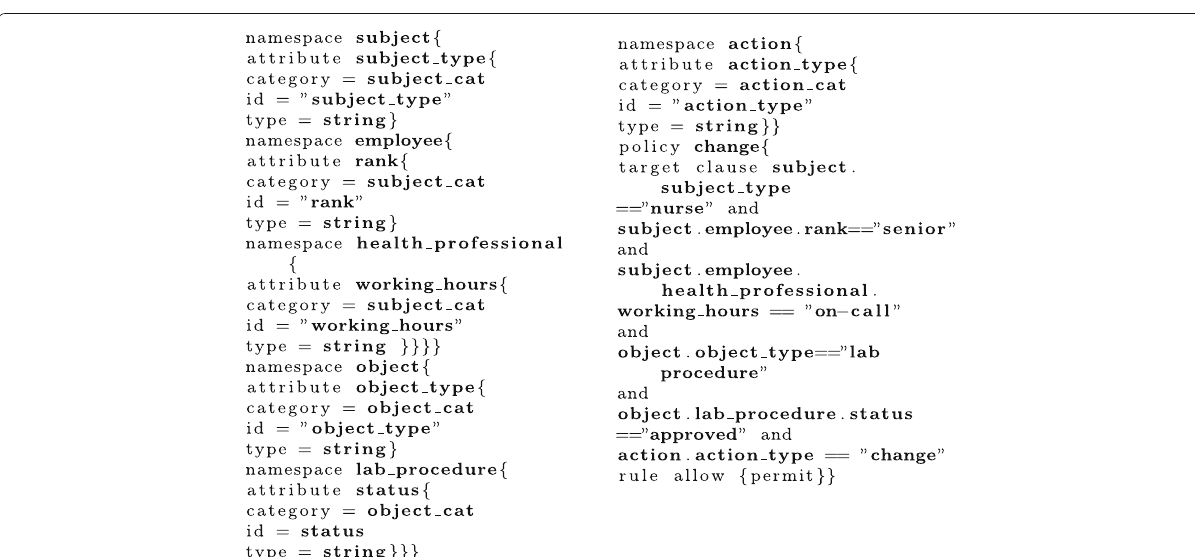
apparent that by having well-defined attributes, building